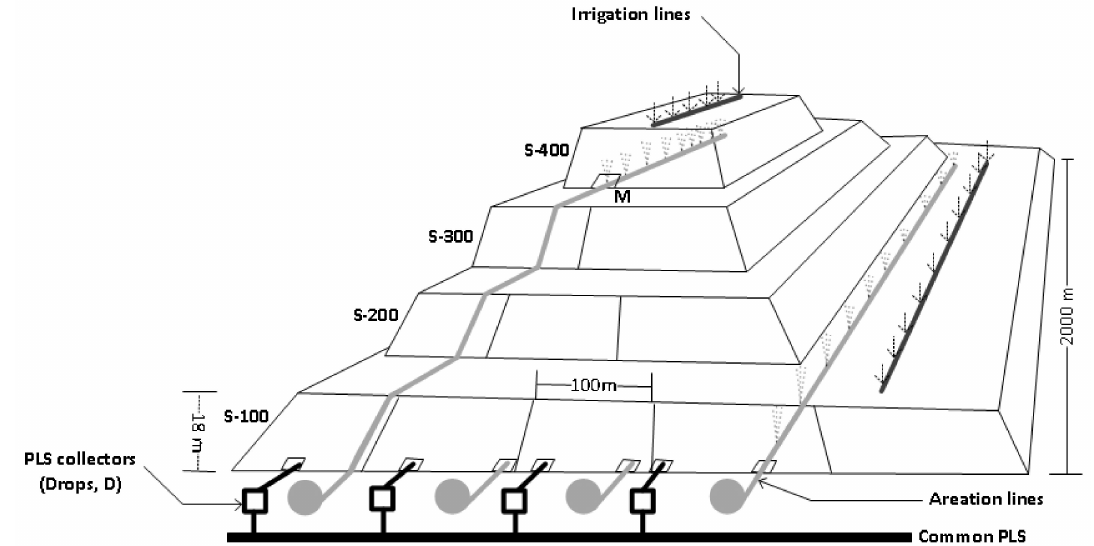
Figure 1. Schematic drawing of the bioleaching heap at Escondida mine with four lifts. D corresponds to drops. M is the base of the fourth lift (adapted from